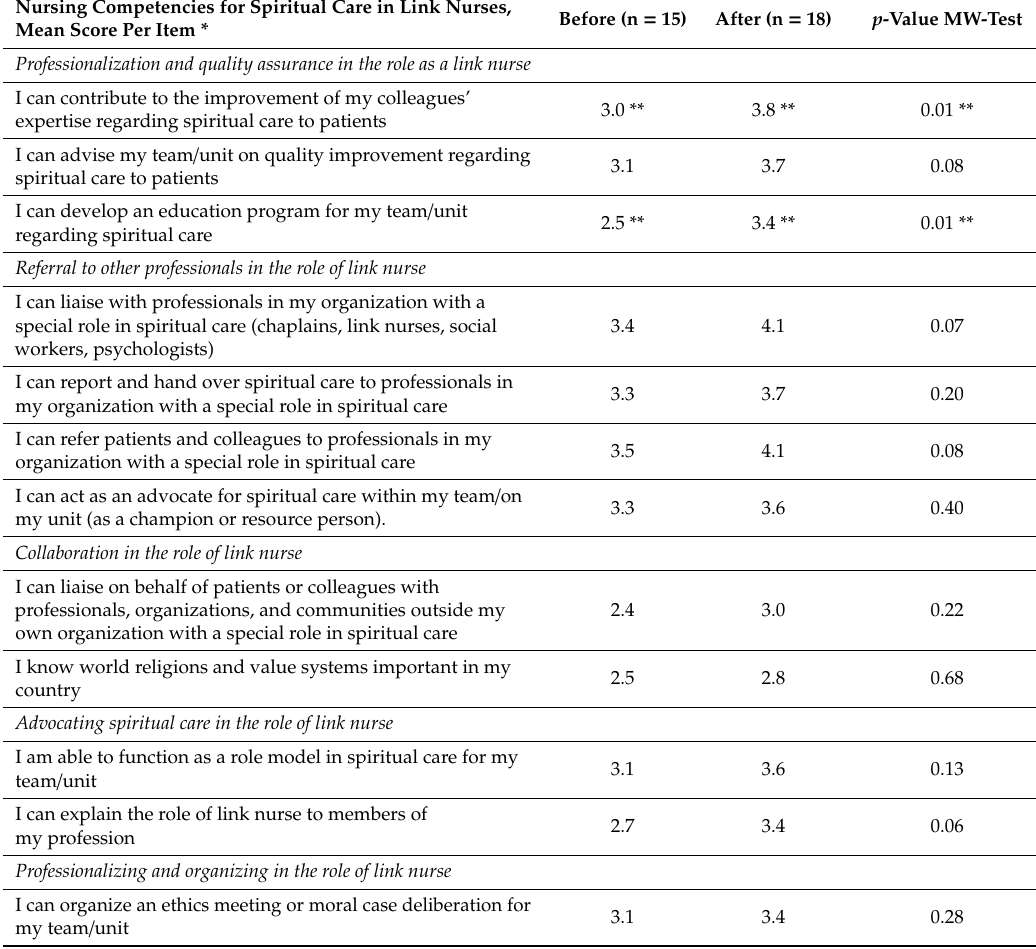
Table 5. Link nurse competencies for spiritual